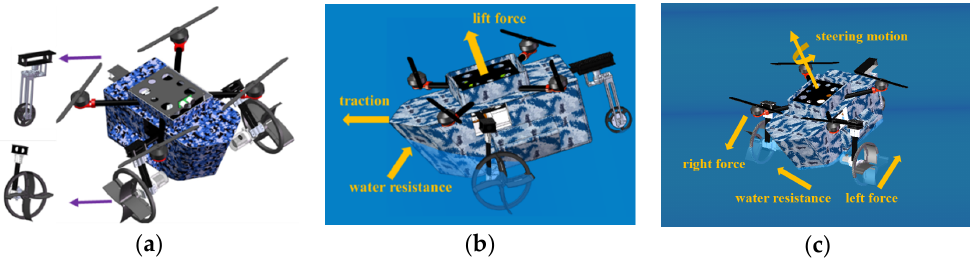
Figure 1. The structure and movement mode of the CDR. ( a ) The structure of the CDR. ( b ) The robot flying on the water surface. ( c ) The robot yaw angle control on the water surface.